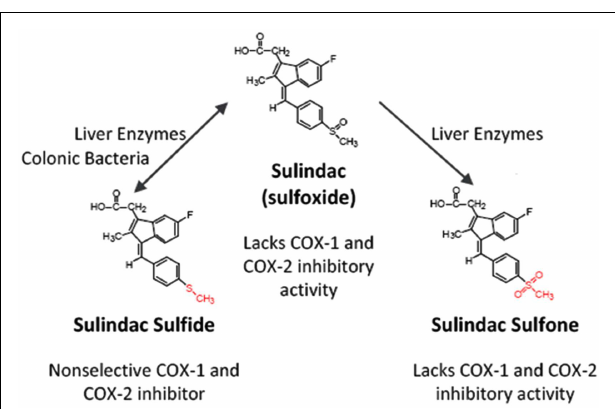
FIGURE 3 | Metabolism of sulindac . Prodrug sulindac undergoes reversible reduction into the active sulfide form through the action of liver enzymes and colonic bacteria. Sulindac sulfide is a non-selective COX inhibitor and is responsible for the anti-inflammatory properties of sulindac. The sulfone metabolite is generated by irreversible oxidation of the sulfoxide in the liver, and does not have anti-inflammatory activity. Both sulindac sulfide and sulindac sulfone have antineoplastic activity in vitro and in vivo